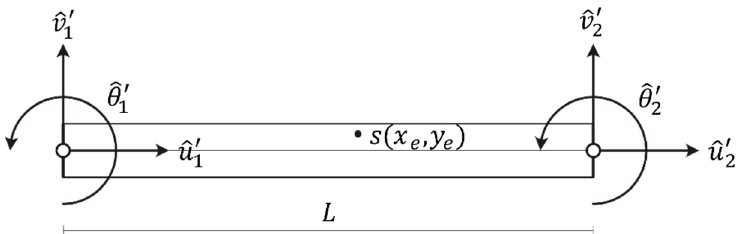
Figure A1. DOFs of a two-dimensional beam element.